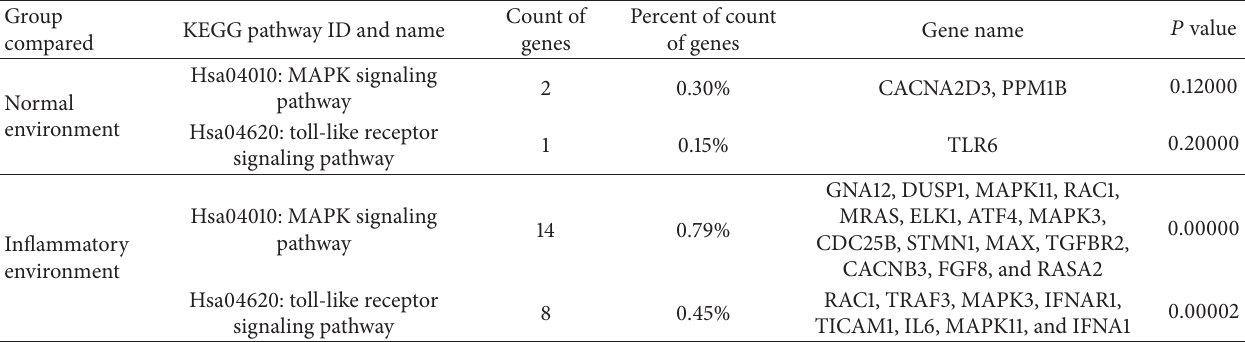
Table 4: Ankylosing spondylitis KEGG pathway analysis